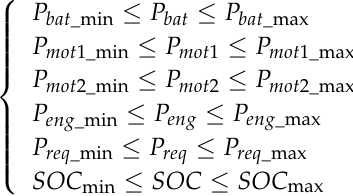
Figure 2. OCV and